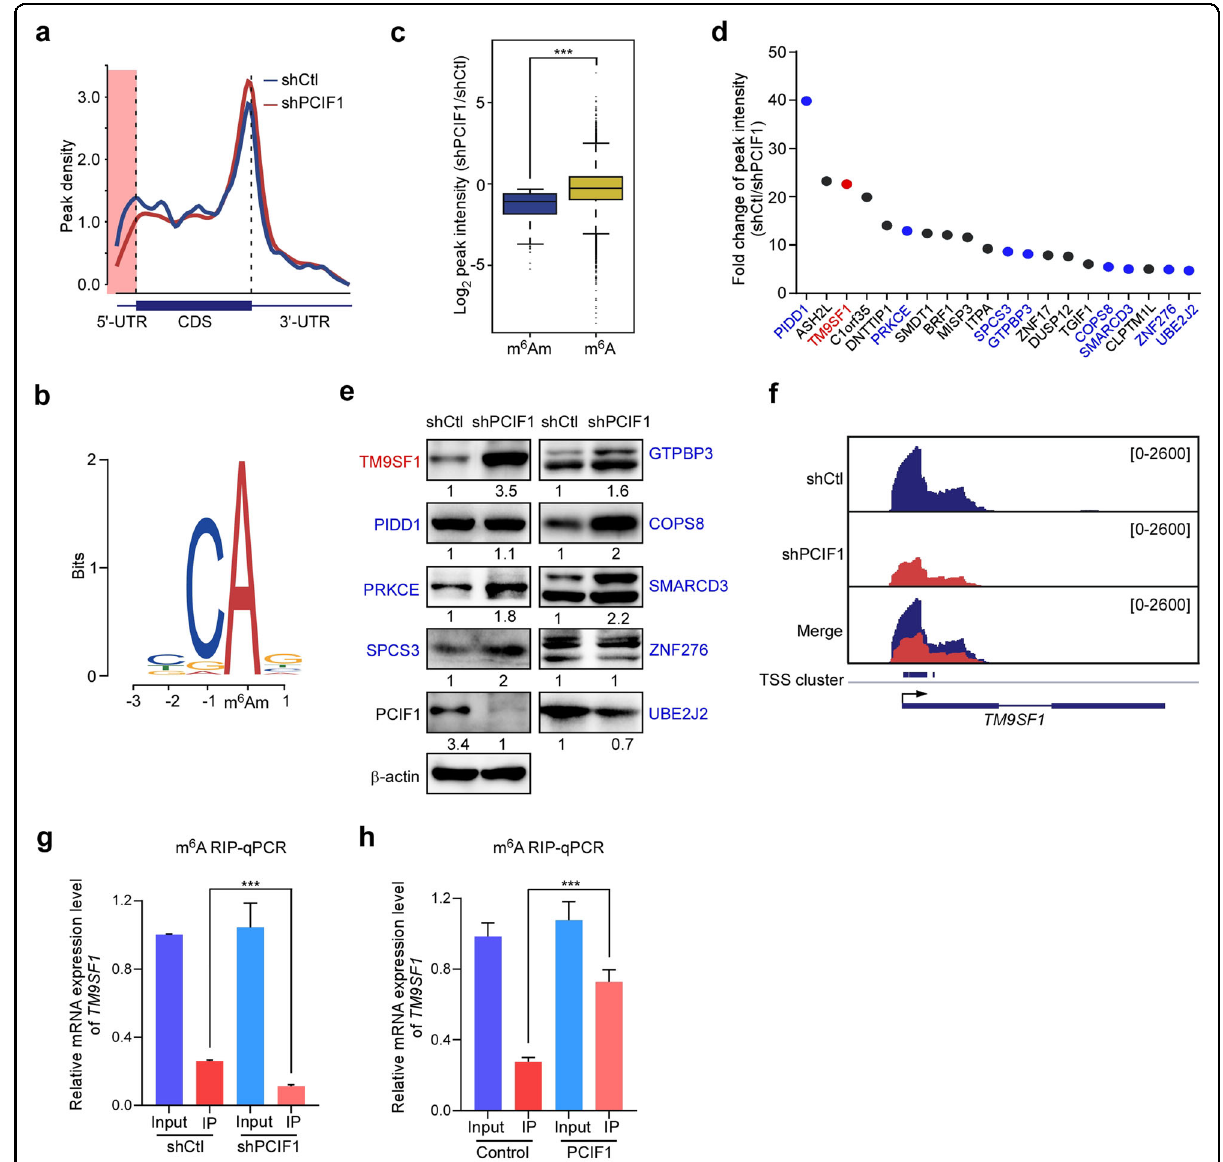
Fig. 3 Identi fi cation of TM9SF1 as a target mRNA of PCIF1. a – c Transcriptome-wide m 6 A-seq analyses of control or PCIF1-depleted AGS cells. Distribution of m 6 A/m 6 Am peaks across mRNA segments in AGS cells ( a ). Each segment was normalized according to its average length by RefSeq annotation. Motif analysis of m 6 Am peaks of mRNAs modi fi ed by PCIF1 in AGS cells ( b ). BCA, A = m 6 Am; B = C, G, or U. E -value = 4.5e − 54. Boxplot analysis of change of m 6 A/m 6 Am peaks intensity in AGS cells upon PCIF1 knockdown is shown ( c ). d m 6 A-Seq analysis of top 20 down-regulated genes in m 6 Am abundance in AGS cells. The data are presented by the fold change of peak intensity (shControl/shPCIF1). ASH2L ASH2 (absent, small, or homeotic)-like, BRF1 BRF1 RNA polymerase III transcription initiation factor subunit, C1orf35 chromosome 1 open reading frame 35, CLPTM1L CLPTM1 (cleft lip and palate transmembrane protein 1)-like, COPS8 COP9 signalosome subunit 8, DNTTIP1 deoxynucleotidyltransferase terminal interacting protein 1, DUSP12 dual speci fi city phosphatase 12, GTPBP3 GTP binding protein 3, mitochondrial; ITPA inosine triphosphatase, MISP3 MISP family member 3, PIDD1 p53-induced death domain protein 1, PRKCE protein kinase C epsilon, SMARCD3 SWI/SNF related, matrix associated, actin dependent regulator of chromatin, subfamily d, member 3, SMDT1 single-pass membrane protein with aspartate rich tail 1, SPCS3 signal peptidase complex subunit 3, TGIF1 TGFB induced factor homeobox 1, TM9SF1 transmembrane 9 superfamily member 1, UBE2J2 ubiquitin conjugating enzyme E2 J2, ZNF17 zinc fi nger protein 17, ZNF276 zinc fi nger protein 276. e Western analysis of the potential target genes of PCIF1 predicted by m 6 A-Seq and Kaplan – Meier survival curves (Supplementary Fig. S4) in control and PCIF1-depleted AGS cells. And intensities of PCIF1 potential target genes in PCIF1-depleted cells compared to those in control cells are shown. f The analysis of m 6 A/m 6 Am peaks on TM9SF1 gene in control and PCIF1-depleted AGS cells. g , h m 6 A-RIP analysis of TM9SF1 mRNA in AGS cells transfected with the indicated shRNA and plasmids. The enrichment of TM9SF1 mRNA in immunoprecipitation (IP) or input fraction was determined by qRT-PCR. Data are shown as means ± SD. N.S. means not signi fi cant; *** P < 0.001, Student ’ s t